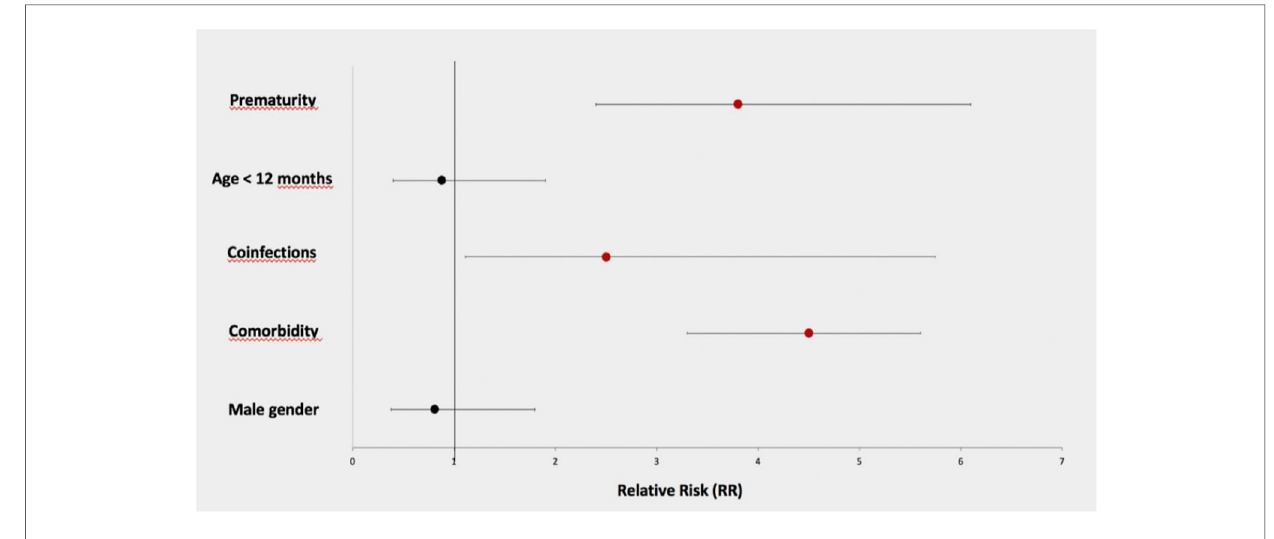
FIGURE 3 Relative risk for each risk